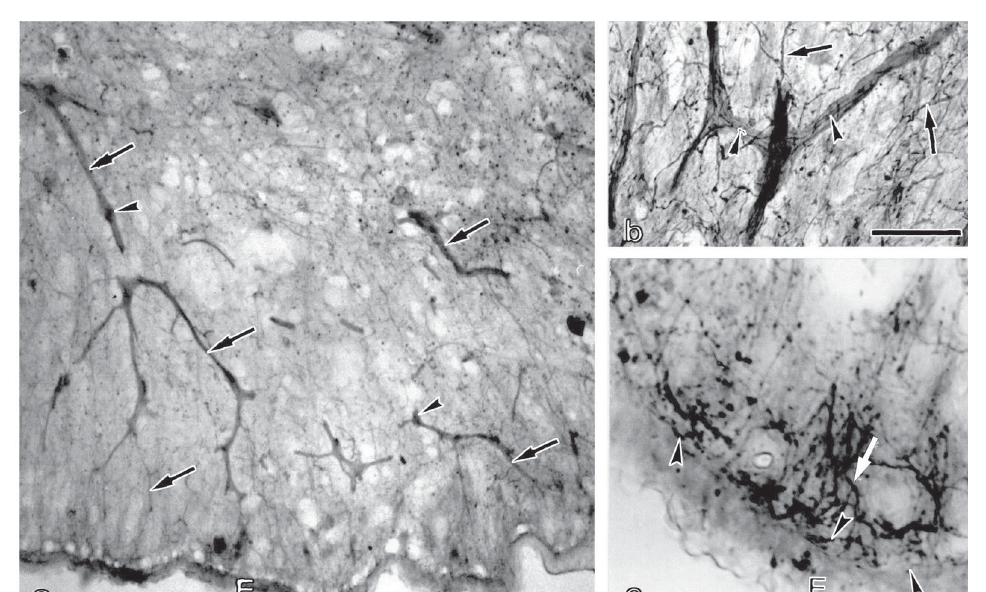
Figure 2. Fluorescent micro- graphs of sections through gan- glia and nerves of the pedal plexus of Megalobulimus oblon- gus. a , b and c , Note the tightly clustered (asterisks) fluorescent fibers in the neuropilar region. Catecholamine (CA) fluorescent axons (arrowheads) entering or exiting the ganglia. Observe 5- HT (double arrow) and CA (ar- row) fluorescent fibers in the nerve fascicles. The ganglion in b presents some CA varicosi- ties surrounding negative neu- ronal bodies (small arrows). A ganglion in c displaying a CA fluorescent neuronal soma (small arrow). Bars: a-c = 20 µm.